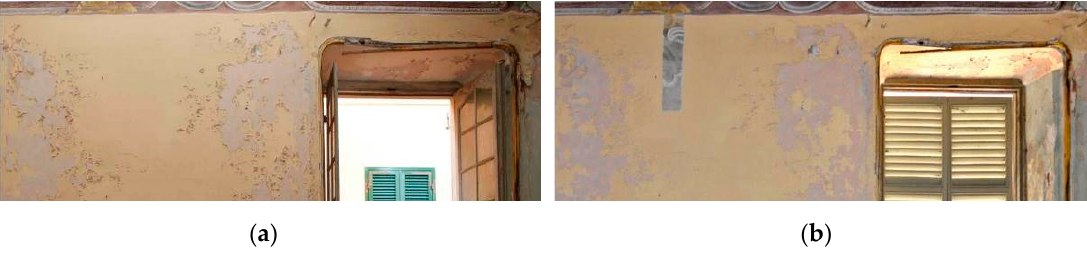
Figure 9. ( a ) Before the stratigraphical analysis (first room) and ( b ) after the stratigraphical